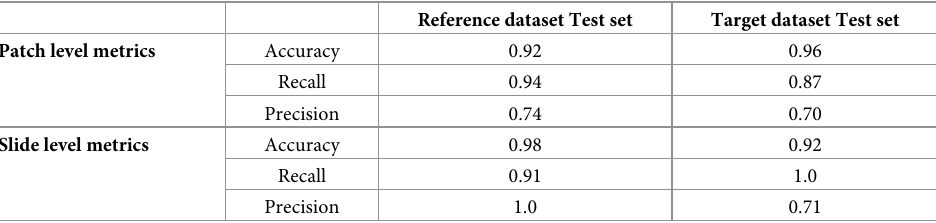
Table 4. Results of the model on test sets 1 and